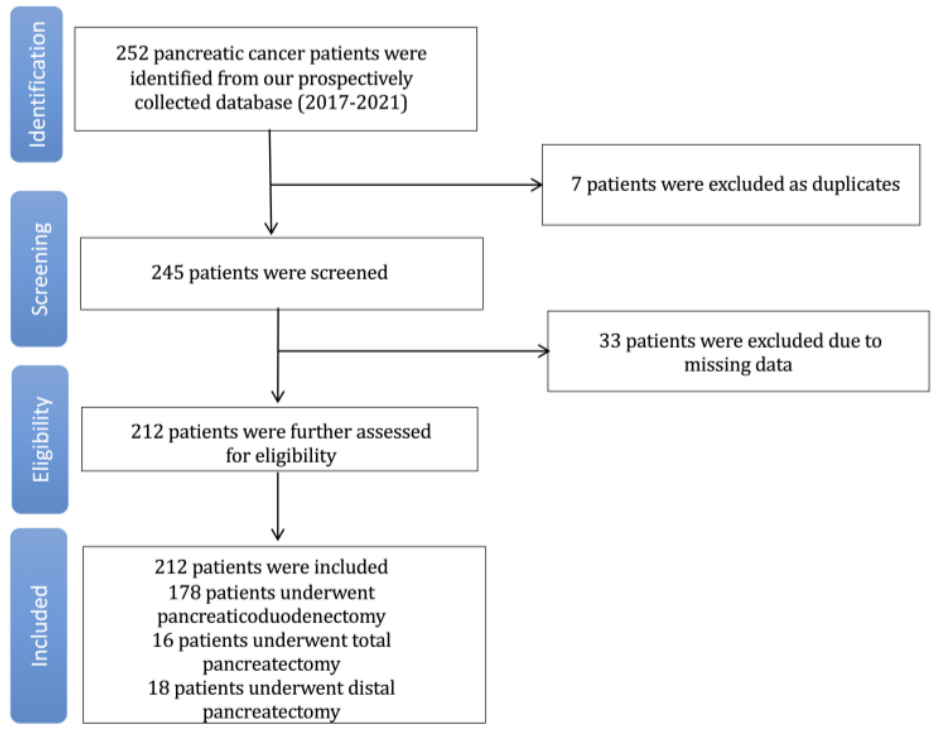
Figure 1. Trial Figure 1. Trial flow. Table 1. Patient baseline characteristics.